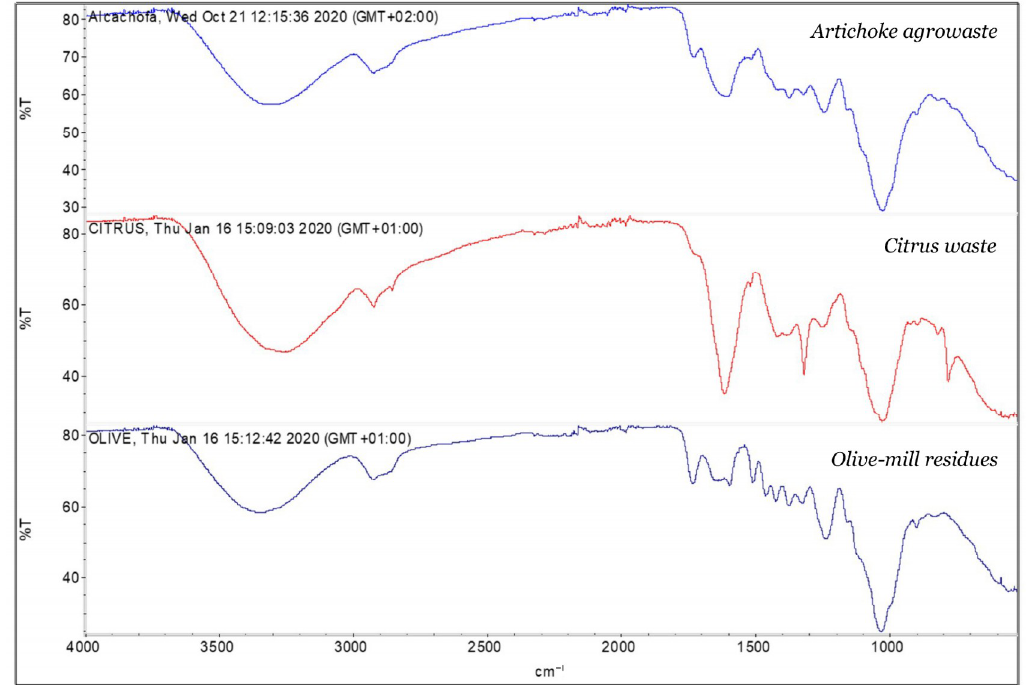
Figure 4. FTIR spectra between 4000 and 400 cm − 1 for sorbent samples.